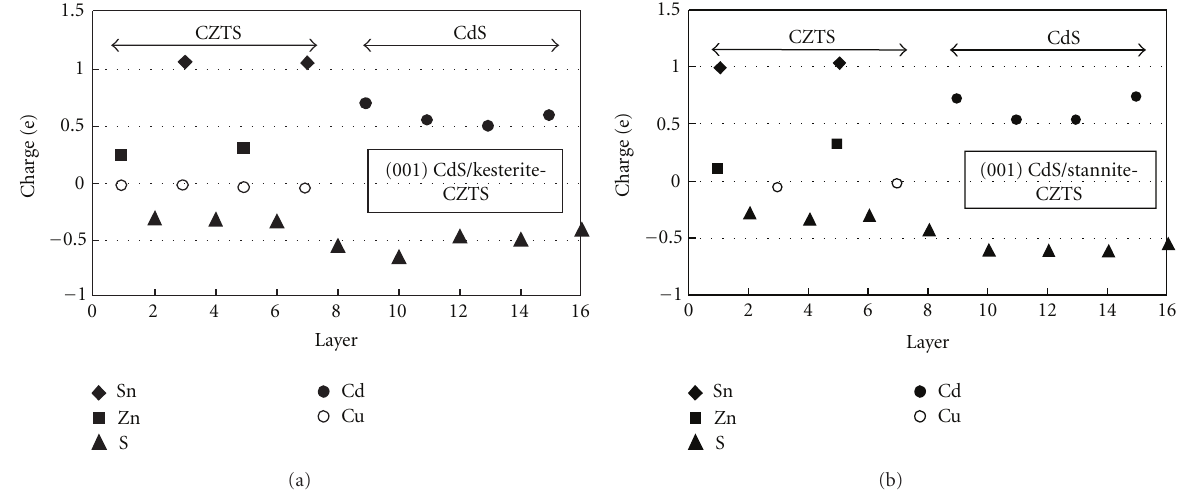
Figure 5: Obtained charge of each atom in the (001)-oriented supercell. (a) CdS/kesterite-CZTS. (b) CdS/stannite-CZTS. the S layers at the (Zn, Sn) interface and layer 8 to the S layer at the (Cu, Cu) interface. As in Figure 3(a), the energy level of a certain kind of atom orbital is dependent on the position (layer number). The energy level tends to be lower near the (Zn, Sn) interface (layer 0 or 16). The valence band o ff set was estimated as Δ E v = 1 . 5 eV for the (Zn, Sn) interface and Δ E = 0 . 6 eV for the (Cu, Cu) interface. The corresponding v conduction band o ff sets are Δ E c = 0 . 6 eV for the (Zn, Sn) interface and Δ E c = − 0 . 3 eV for the (Cu, Cu) interface. If the VBM energy is averaged within each parts, then Δ E v = 1 . 1 eV and Δ E c = 0 . 2